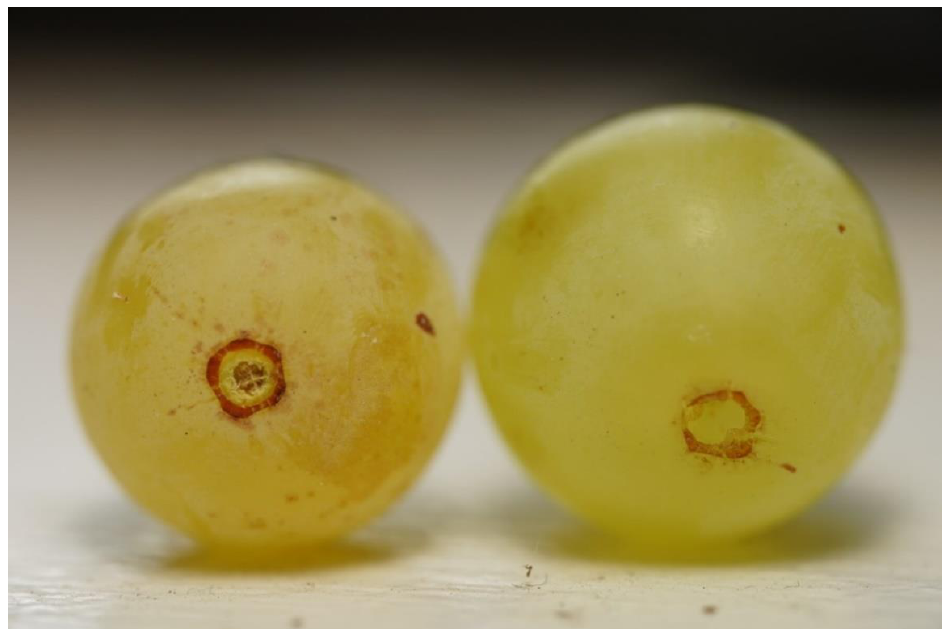
Figure 1. Thompson Seedless grapes treated with an abscission agent develop a dry stem scar ( left ) within a few days after treatment, whereas untreated grapes generally have a wet stem scar after detachment ( right ).